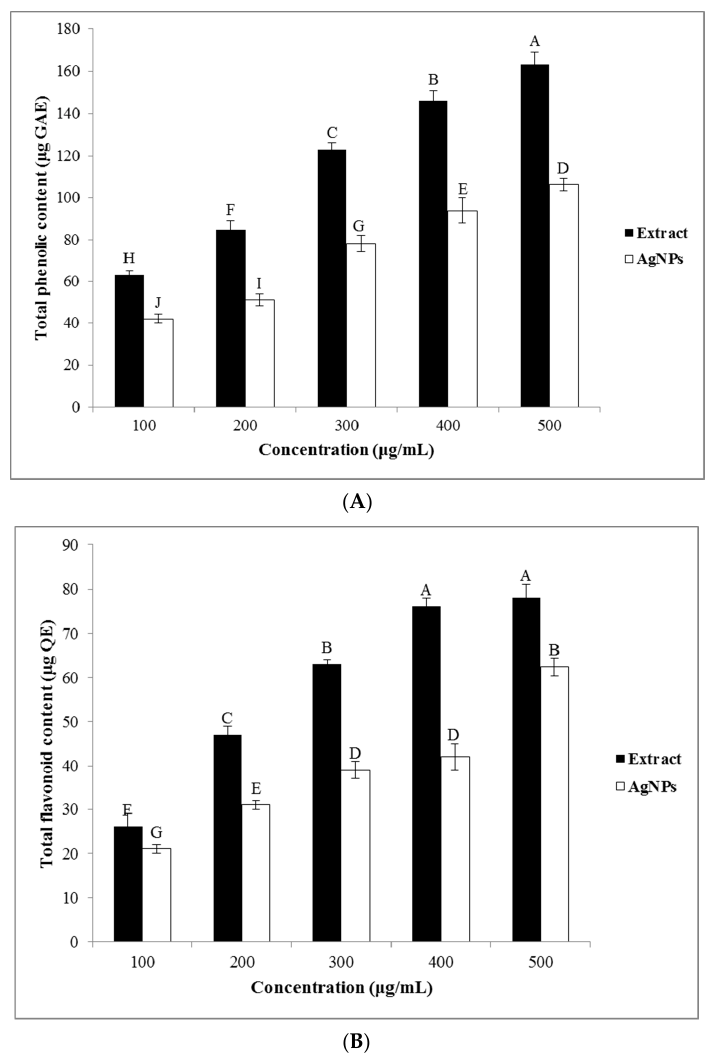
Figure 4. ( A ) Total phenolics and ( B ) total flavonoids content of the A. tribuloides root extract and the greenly synthesized AgNPs at various concentrations. Various letters represent significant differences ( p < 0.05) between the A. tribuloides root extract and the greenly synthesized AgNPs at various concentrations, and also among various concentrations of each of the A. tribuloides root extract and the greenly synthesized AgNPs based on Duncan’s test.